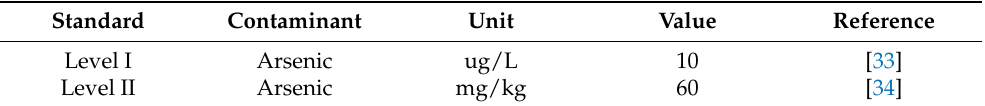
(Table 1): level I, the As concentration in groundwater does not exceed 10 ug/L [33]; level II, the As concentration in groundwater is less than 10 ug/L. Meanwhile, the As content in the soil is less than 60 mg/kg [34]. Table 1. Optimal contaminant limits in this